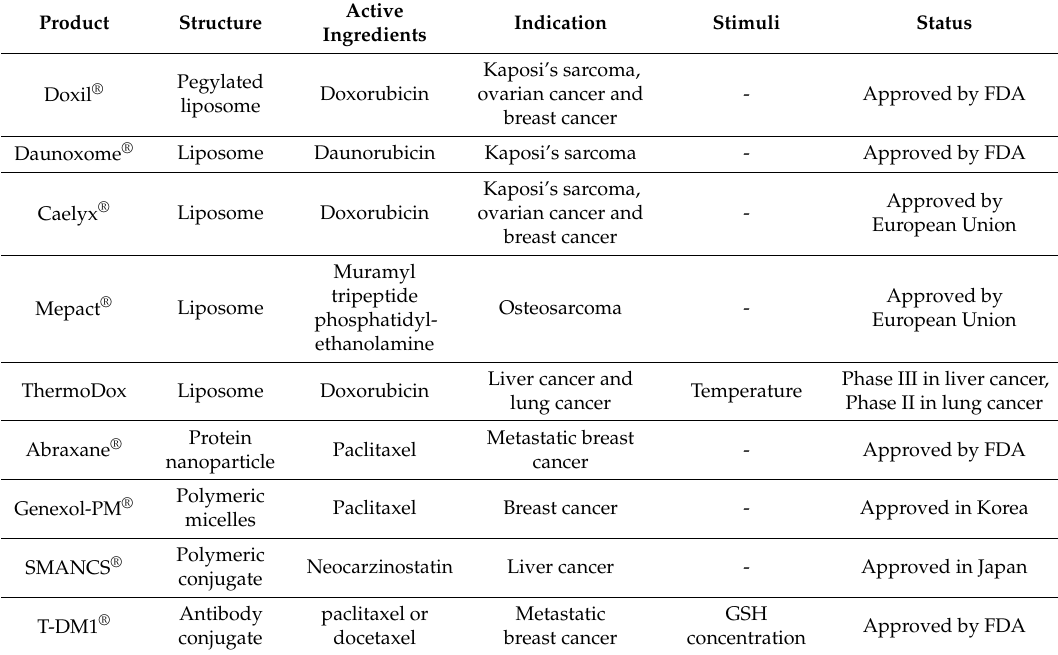
Table 2. Representative examples of DDS